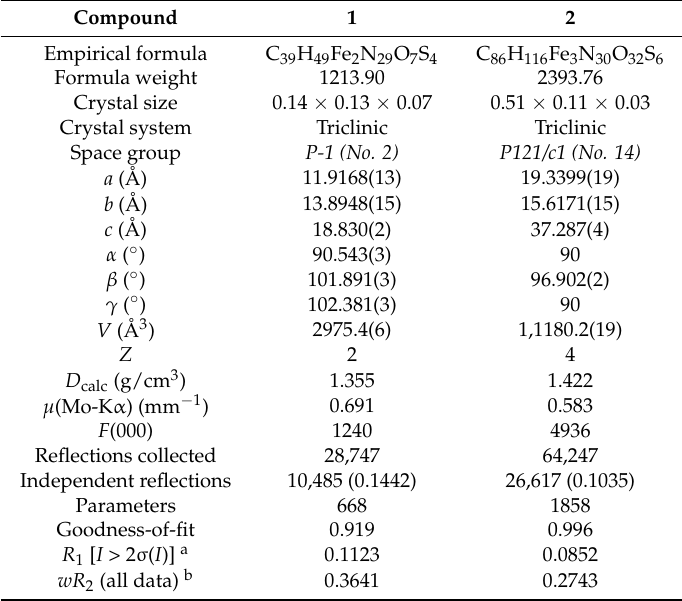
Table 1. Crystallographic Data and Refinement Parameters for Compounds 1 and 2